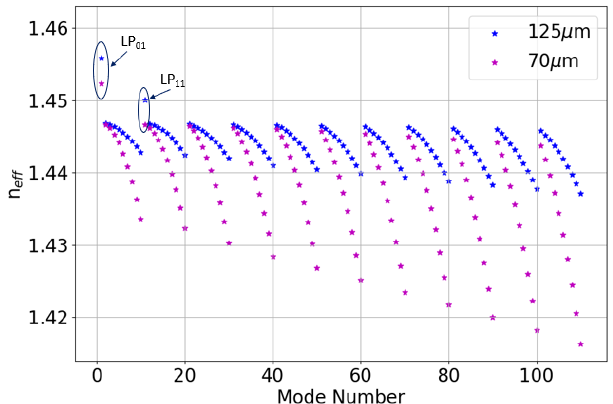
Figure 4. Variation of effective refractive